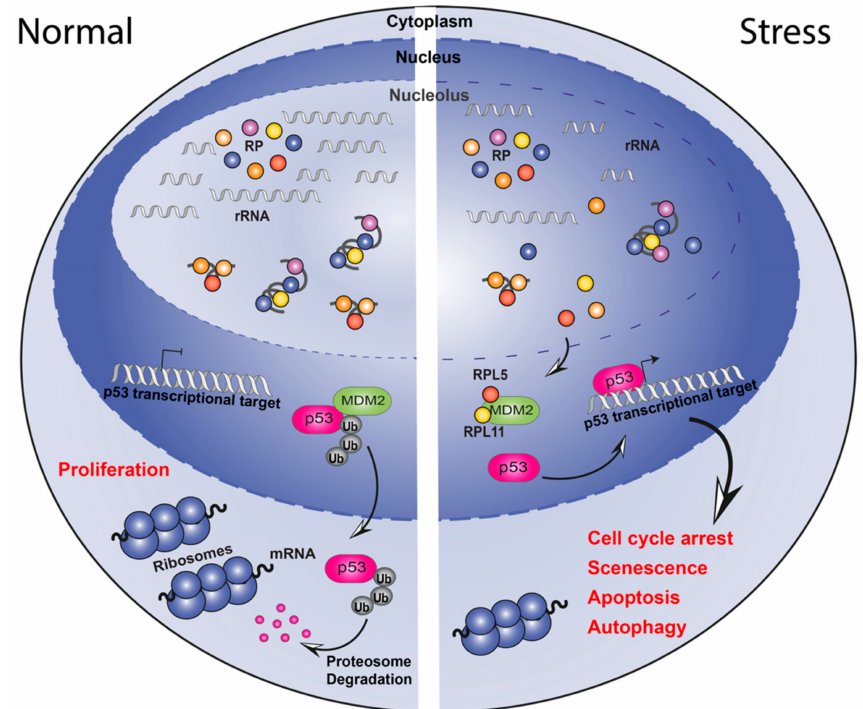
Figure 2. Schematic representation of the nucleolar surveillance pathway. Under normal growth conditions (left), ribosomal proteins (RPs) are assembled with ribosomal RNA into the 40S and 60S subunits in the nucleolus. p53 activity is maintained at low levels by ubiquitin-mediated degradation induced by MDM2. Following nucleolar stress (right), ribosome biogenesis is halted thus RPs, rRNAs, and other nucleolar proteins are released into the nucleoplasm. RPL5 and RPL11 are free to bind to MDM2 and prevent p53 ubiquitylation. p53 is then available for regulation of its target genes leading to cellular responses like cell cycle arrest, senescence, apoptosis and